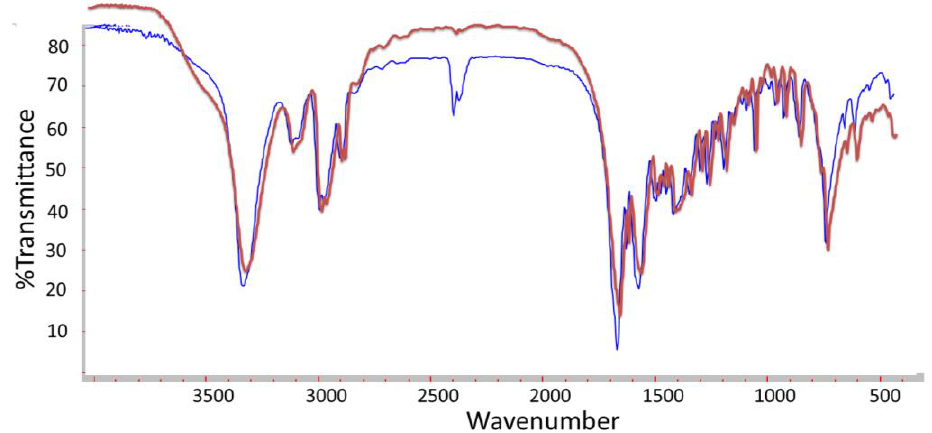
Figure 4. IR spectra of the pure M6 (red) and M6 carrying 2% Ag NPs (blue)